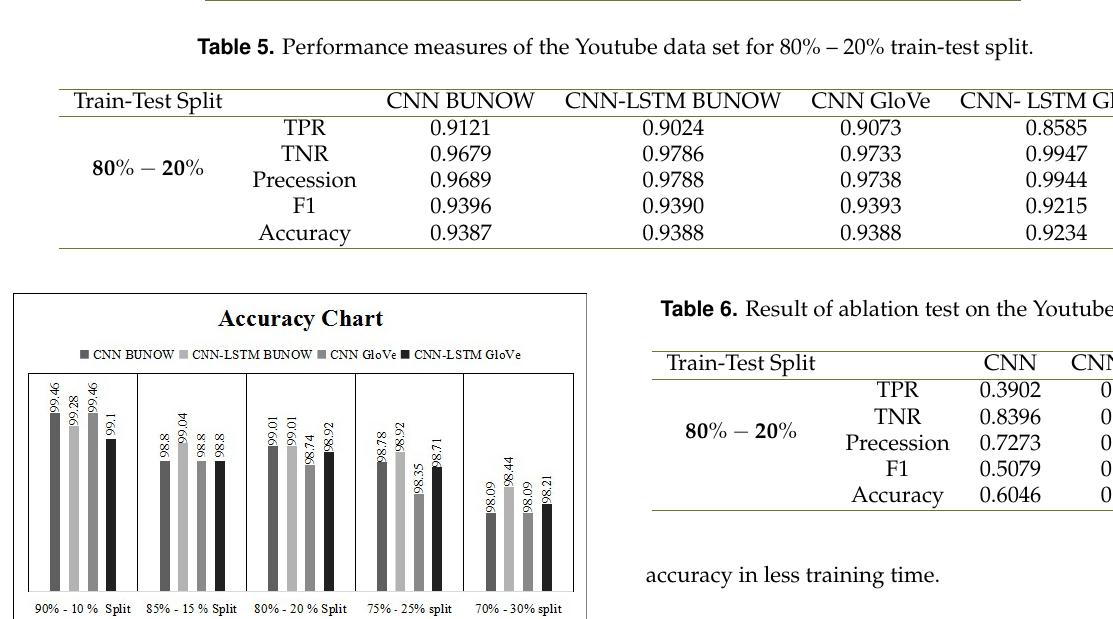
architecture and perform a 10-fold cross-validation which takes huge time on training the model. The CNN-LSTM